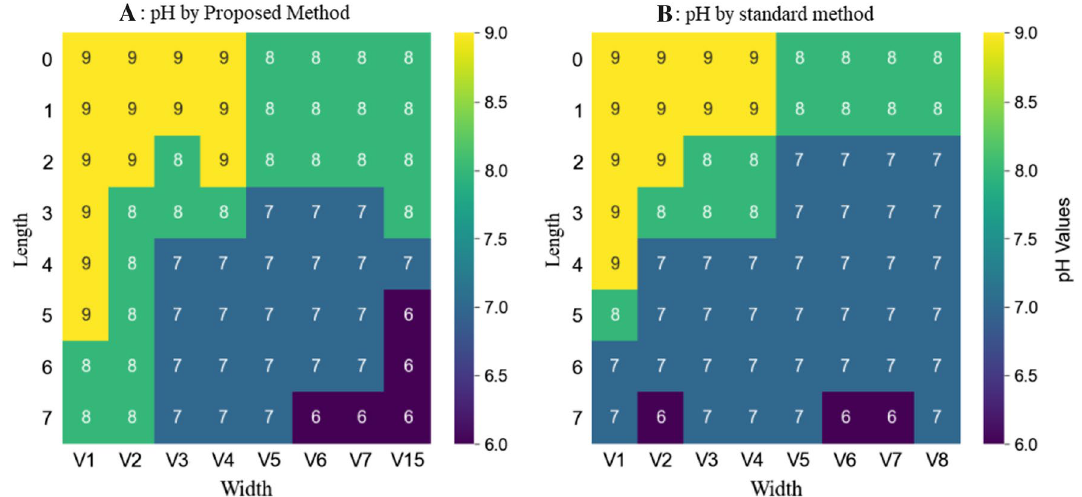
Fig. 14 pH observations by two